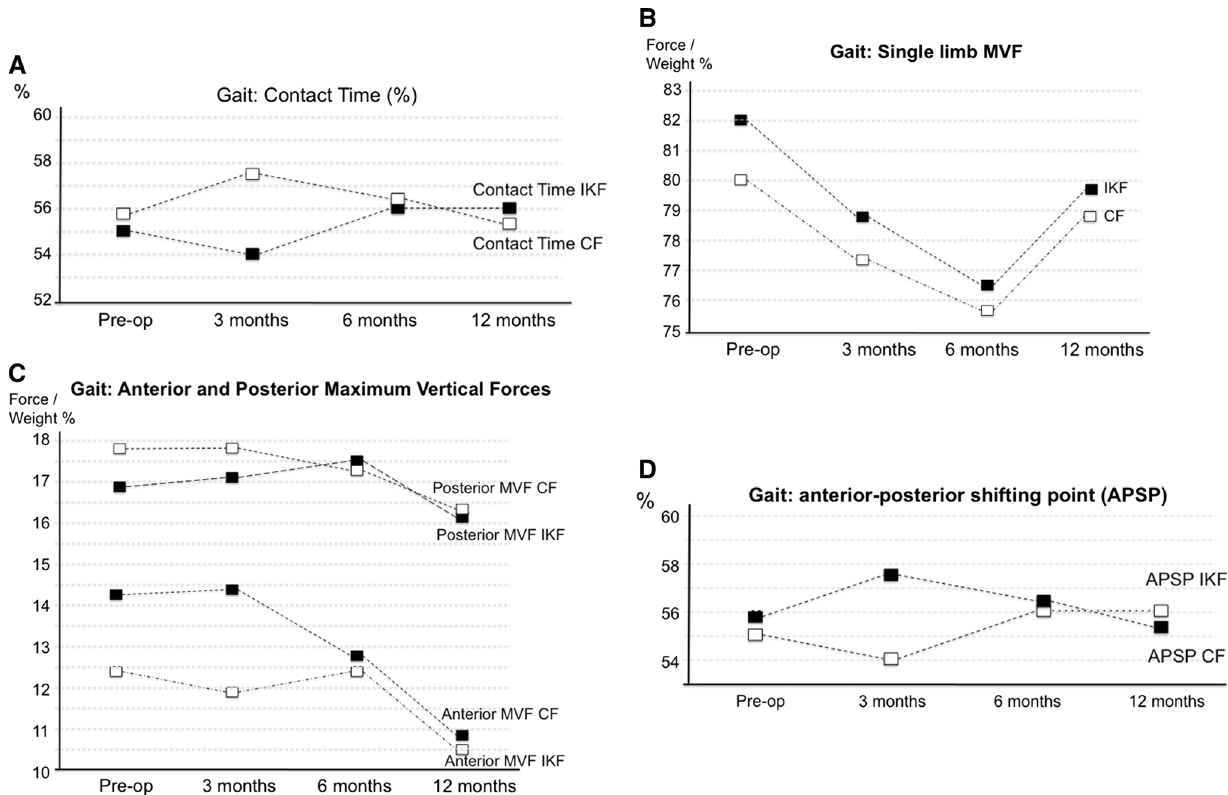
perform a maximum jump after landing. The box distance was adjusted so that the patient could land with one foot on each platform. c Vertical hop test and kinetics graph. Vertical hop test was performed (Fig. 2c) with the patient standing on both platforms and being instructed to hop using his arms as countermovement. Max maximum